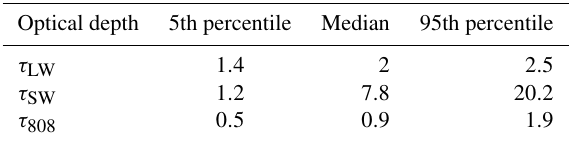
Table B1. Statistical range (5th, 50th and 95th percentiles) of three different estimations of optical depth: τ LW (from the downwards longwave flux), τ SW (from the downwards shortwave flux) and τ 808 (calculated from the IAOOS lidar profiles). For a robust compari- son, τ LW and τ SW values considered here are interpolated on the IAOOS profile times. The percentiles are therefore established over 54 data points which correspond to the 54 IAOOS profiles. Individ- ual errors carried over from measurement errors on LWd, SWd and T 2m are in the range 8%–19% (mean 11%) for τ SW and 8–23% (mean 13%) for τ LW